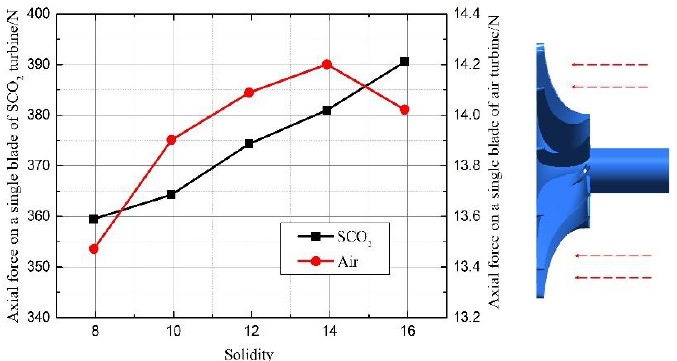
Figure 16. Axial force of a single rotor blade with di ff erent solidity and working